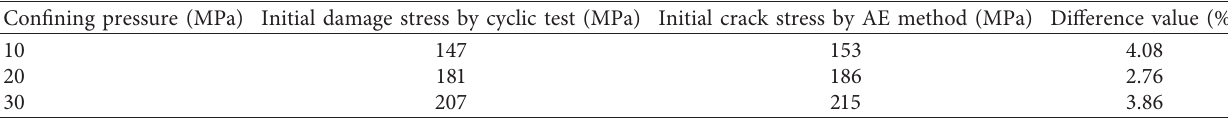
Figure 11: Stress-strain curves in ascending step cyclic loading tests: (a) initial damage point under 20MPa confining pressure; (b) initial damage point under 30MPa confining Table 5: Initial damage stress by cyclic test and initial crack stress by the AE method.